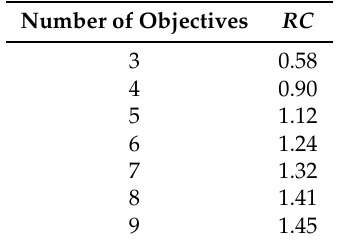
Table 3. Random consistency